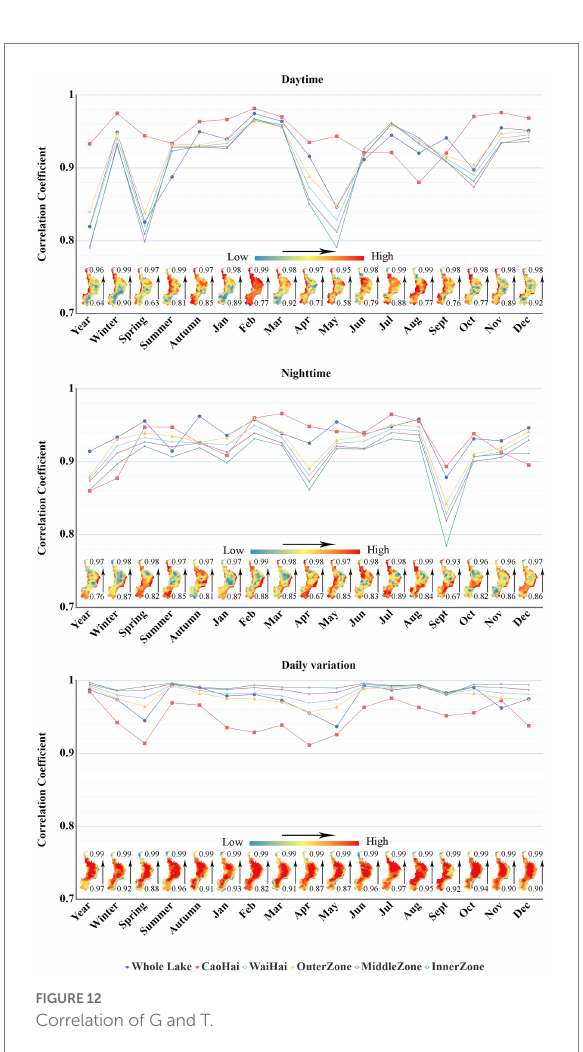
FIGURE 12 Correlation of G and